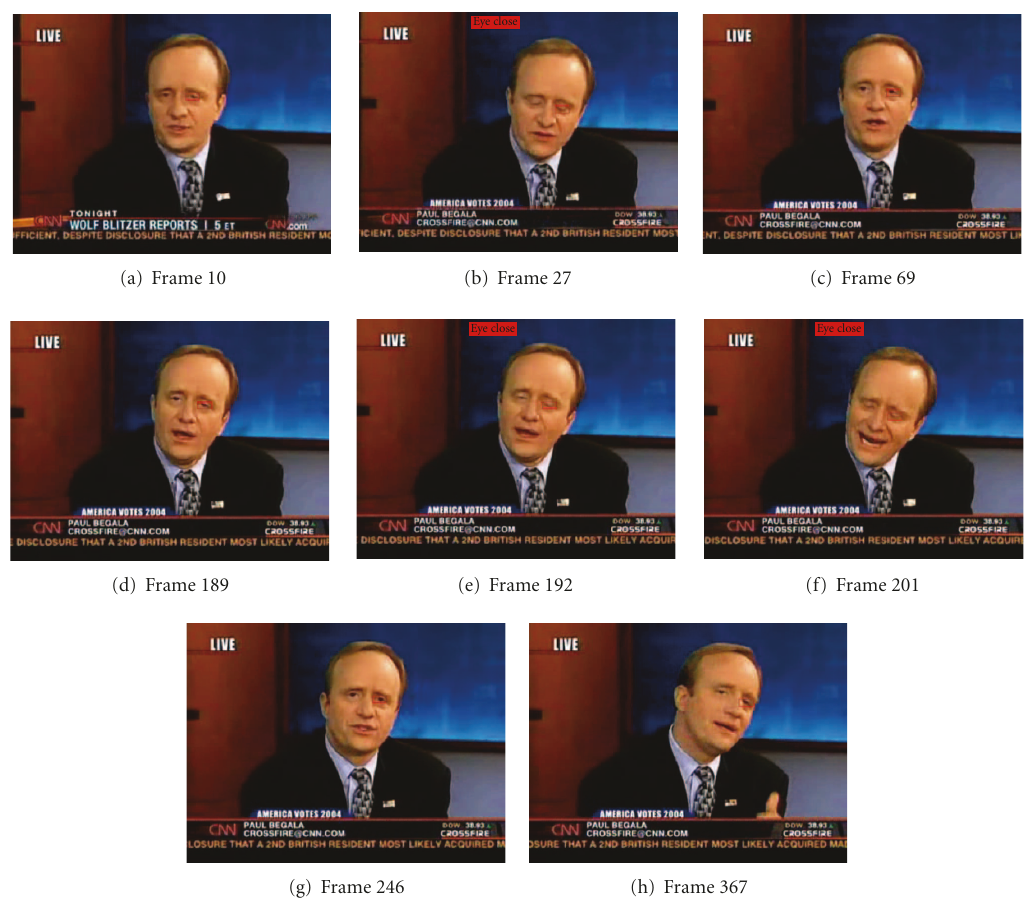
Figure 8: Examples of the blink detection results for news report videos. Red boxes are tracked eyes, and the blue dots are the center of the eye locations. The red bar on the top-left indicates the presence of closed eyes.